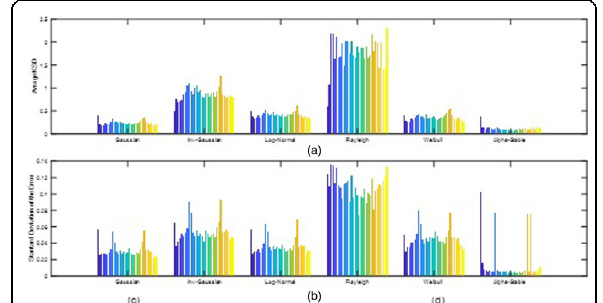
Fig. 18 Estimation results for Vistex images. a Average KSD value for different distributions in each subband. b Standard deviation of the error